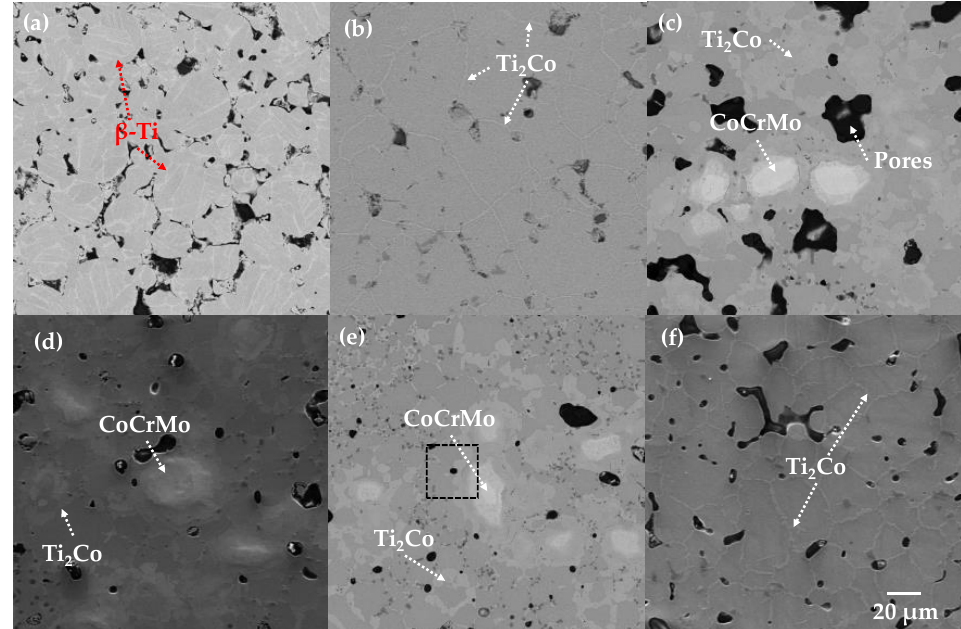
Figure 8. SEM BSE (back-scattered electron) micrographs of the ( a ) Ti6Al4V and composites with different vol.% of CoCrMo particles: ( b ) 10, ( c ) 15, ( d ) 20, ( e ) 25 and ( f ) 30.